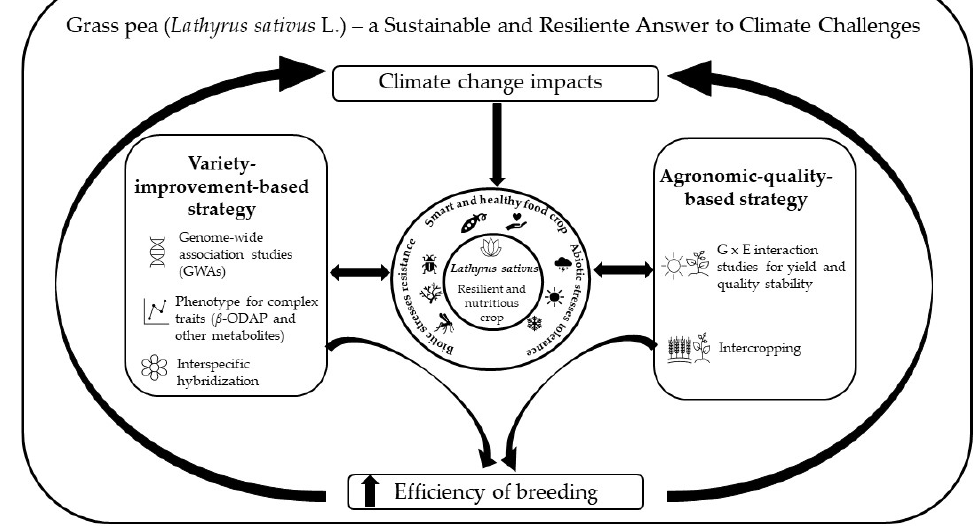
Figure Figure 1. Integrative perspective that includes both agronomic-quality-based and variety-improve- ment-based strategies regarding grass pea improvement toward an efficient answer to climate change